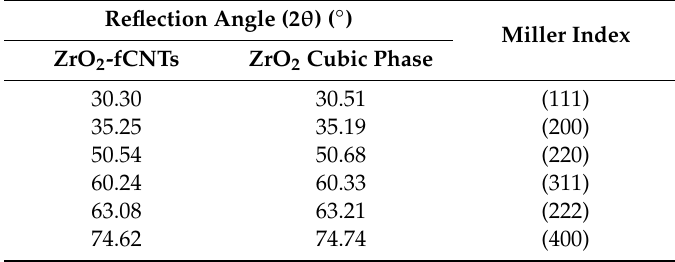
Table 4. Di ff raction angle values of ZrO 2 -fCNTs and ZrO 2 , and their miller